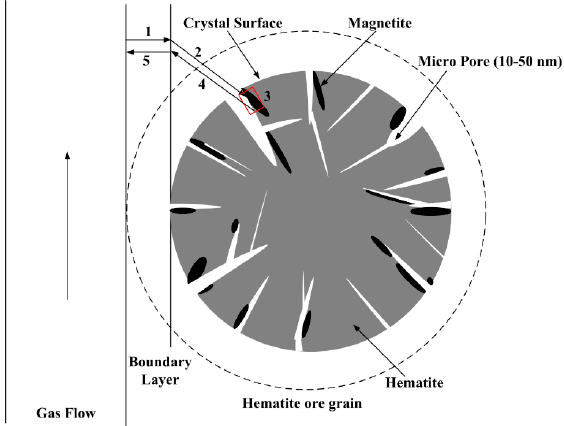
Figure 11. Physical and chemical processes around and inside the hematite ore grain in the micro-fluidized bed reactor: steps 1 and 5 represent thediffusion through the gas boundary layer situated around the hematite ore grain; steps 2 and 4 represent the gas diffusion through the pores of the hematite ore grain; step 3 represents the phase–interface reaction at the crystal surface, and the diffusion of the iron ions through the dense magnetite